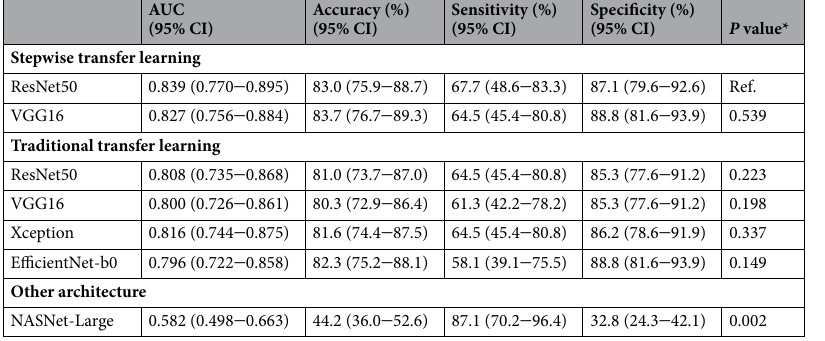
Table 1. The average performance metrics with 95% confidence intervals (CIs) for the stepwise transfer learning and other methods on the fivefold cross-validation for predicting cases of refractory central serous chorioretinopathy (CSC). *The AUCs were compared using the DeLong’s method.